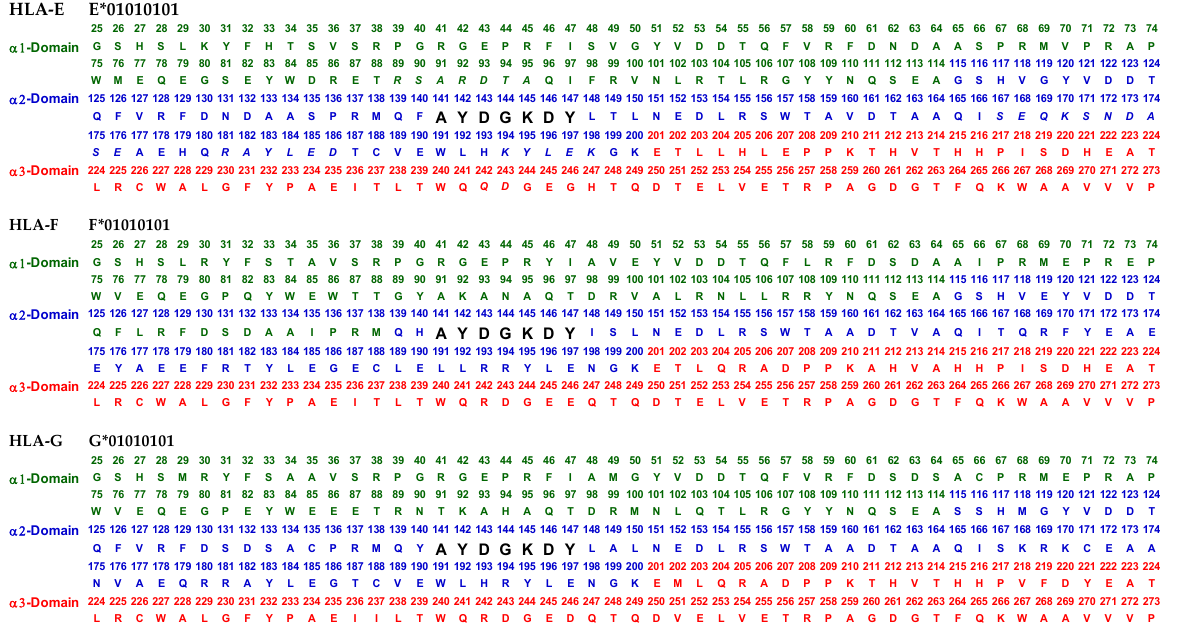
Figure 3. Exposed and cryptic amino acid sequences (in α 2 domain) of non ‐ classical HLA ‐ I (HLA ‐ Ib) on the cell ‐ surface.